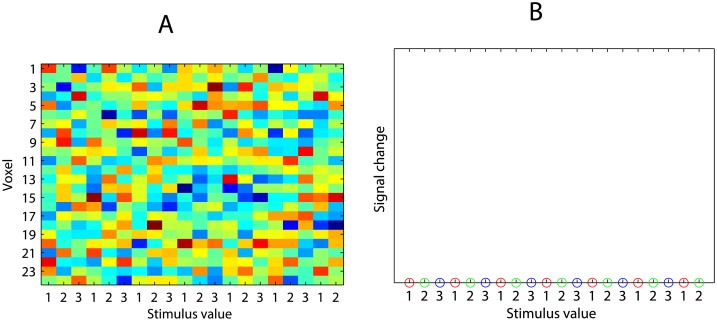
Simulation of sensory adaptation, z-scoring.(A) Voxels’ responses with sensory adaptation.; z-scored. (B) Average responses of voxels as column-wise means of the response matrix.